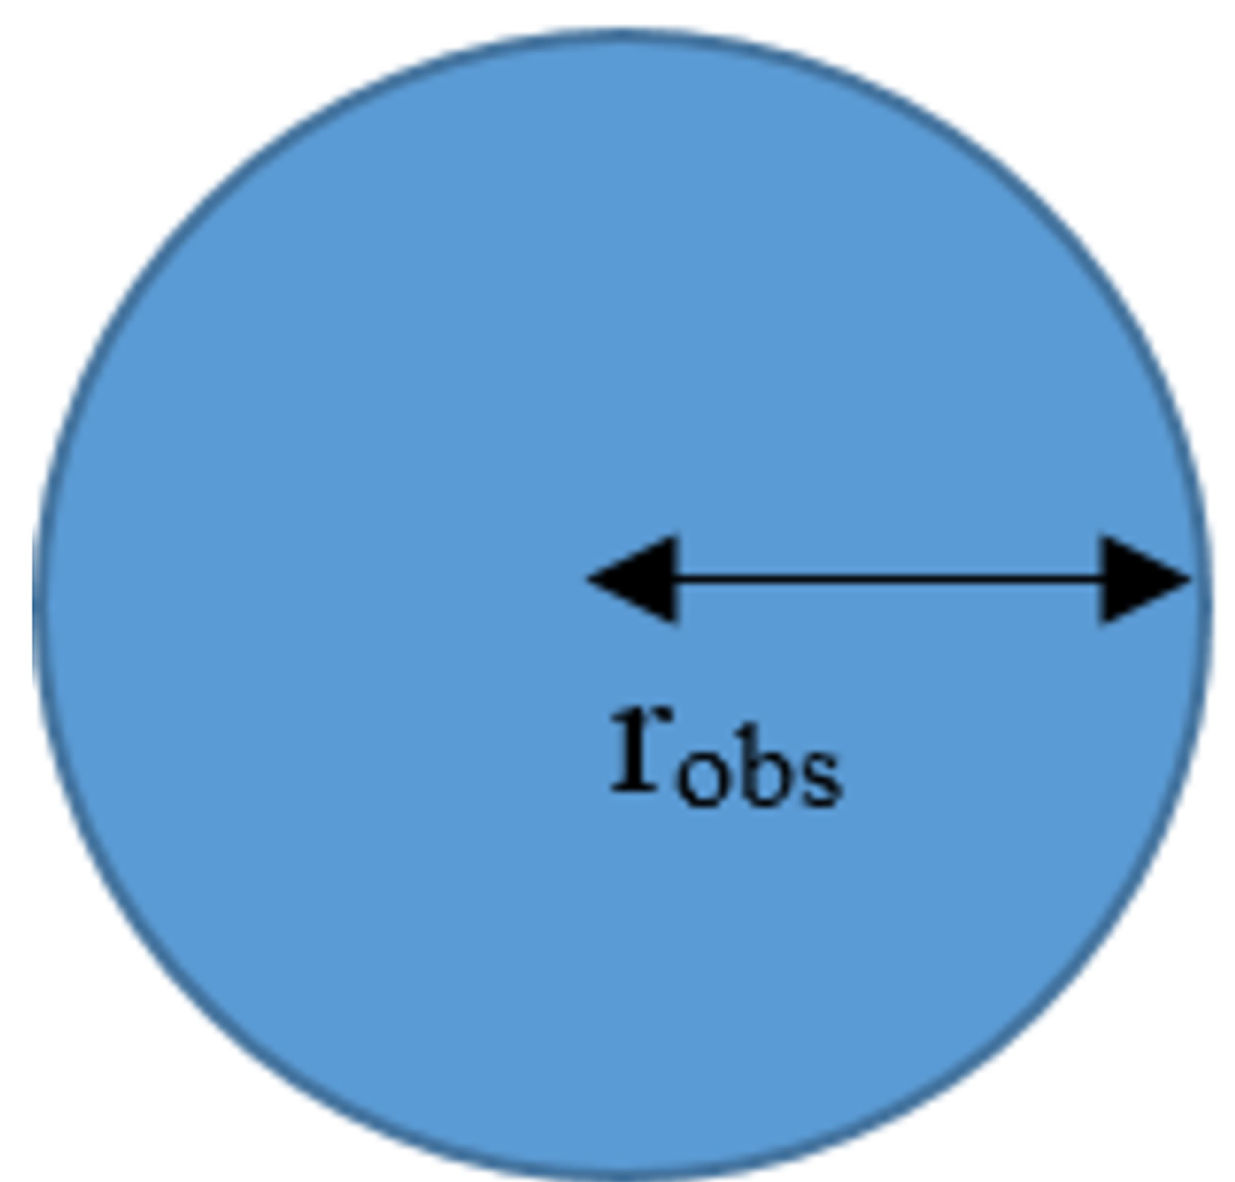
Fig 1. Characteristics of the